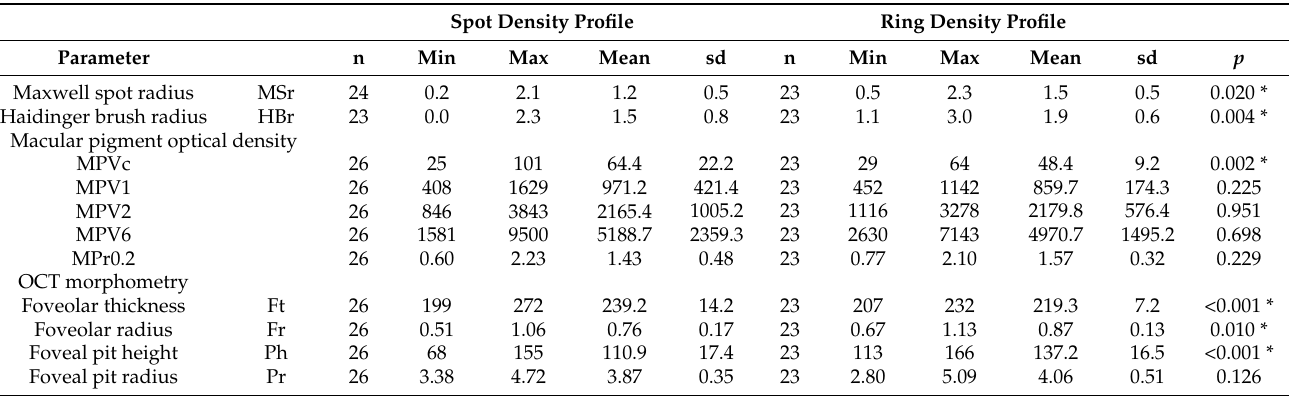
Table 2. Results for cases categorized into spot (category 1) and ring macular pigment density profile categories (categories 2 + 3). The final column contains p -values for 2-tailed independent two-sample t-tests comparing the given parameter in spot and ring macular pigment